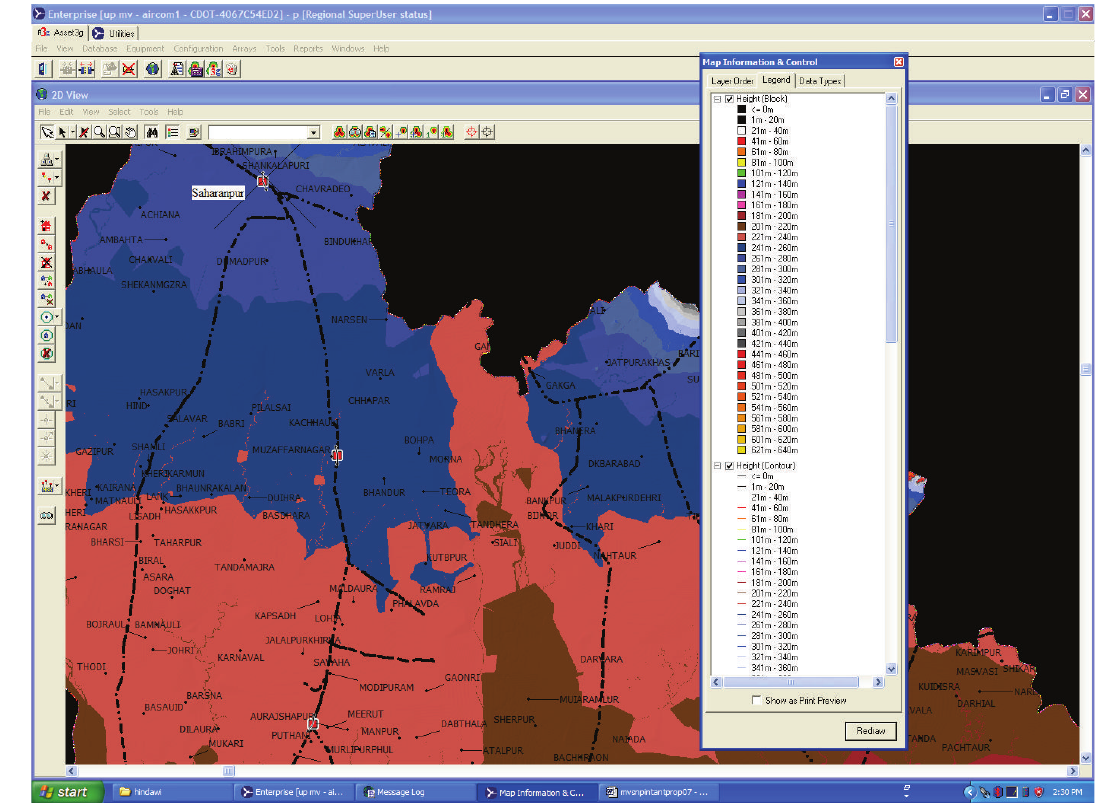
Figure 2: Terrain variation of north Indian base